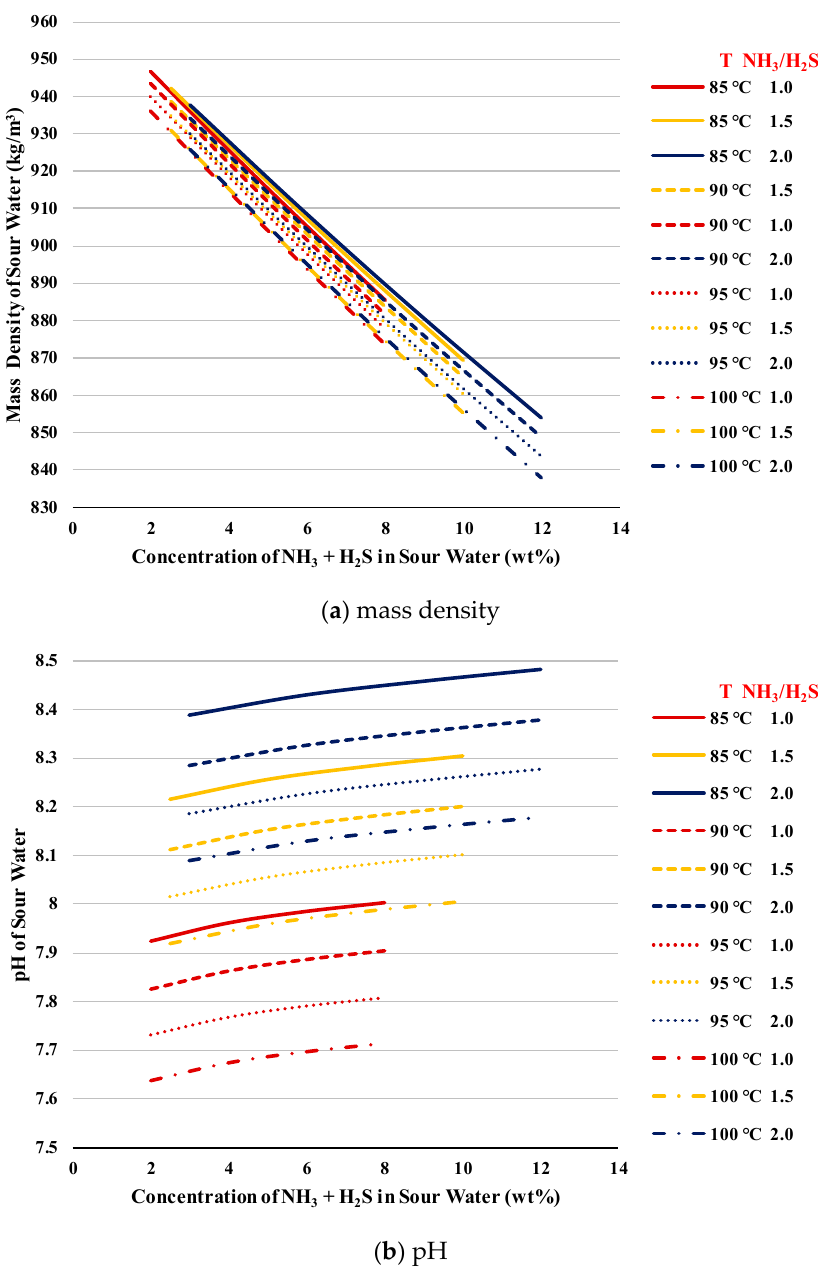
Figure 2. Effects of temperature and concentrations of NH 3 and H 2 S on the sour water properties. The right-hand-side terms of Equations (1) and (2) are statistically significant judged via the probability p -value < 0.05. The coefficients of determination (R 2 ) of both models are higher than